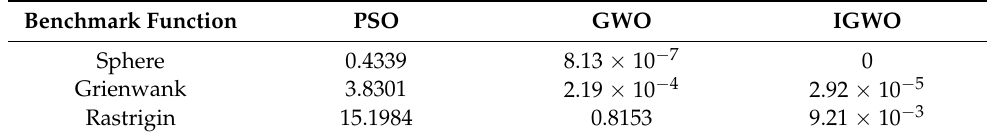
Table 5. Mean square error test results of different models. Benchmark